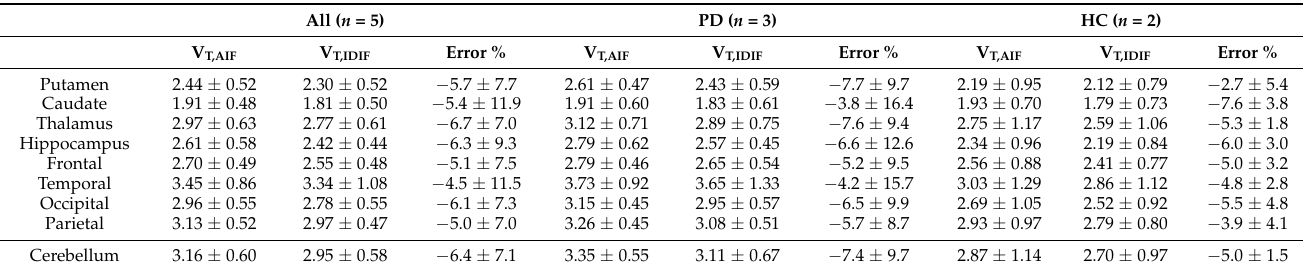
Table 1. Comparison between the V T,AIF and V T,IDIF in the blood-sampling cohort. Overall error is − 5.8 ± 7.8% for V T,IDIF when compared to V T,AIF . The error does not appear to be dependent on the target region.